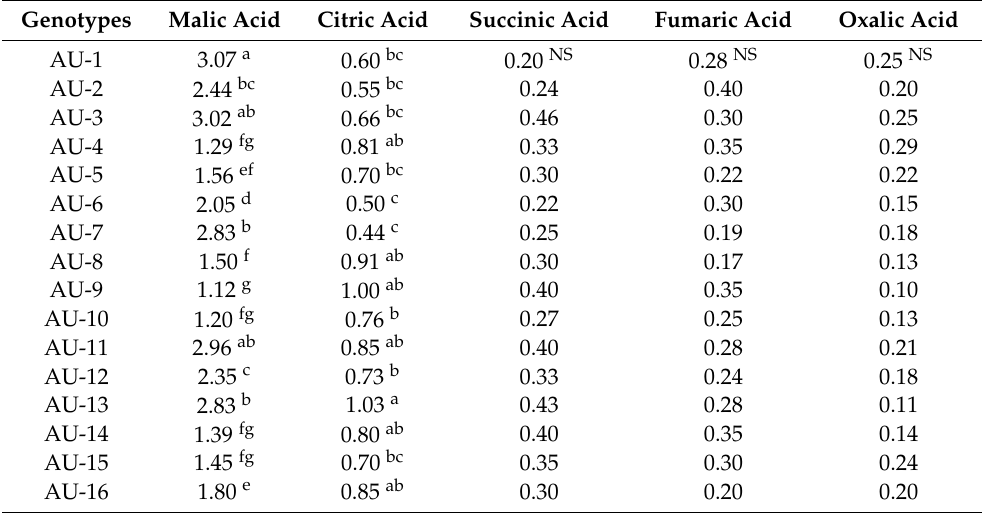
Table 3. Organic acid concentration in fruits of strawberry tree genotypes (average of 2017–2018 years) (g / 100 g FW). Genotypes Malic Acid Citric Acid Succinic Acid Fumaric Acid Oxalic Acid AU-1